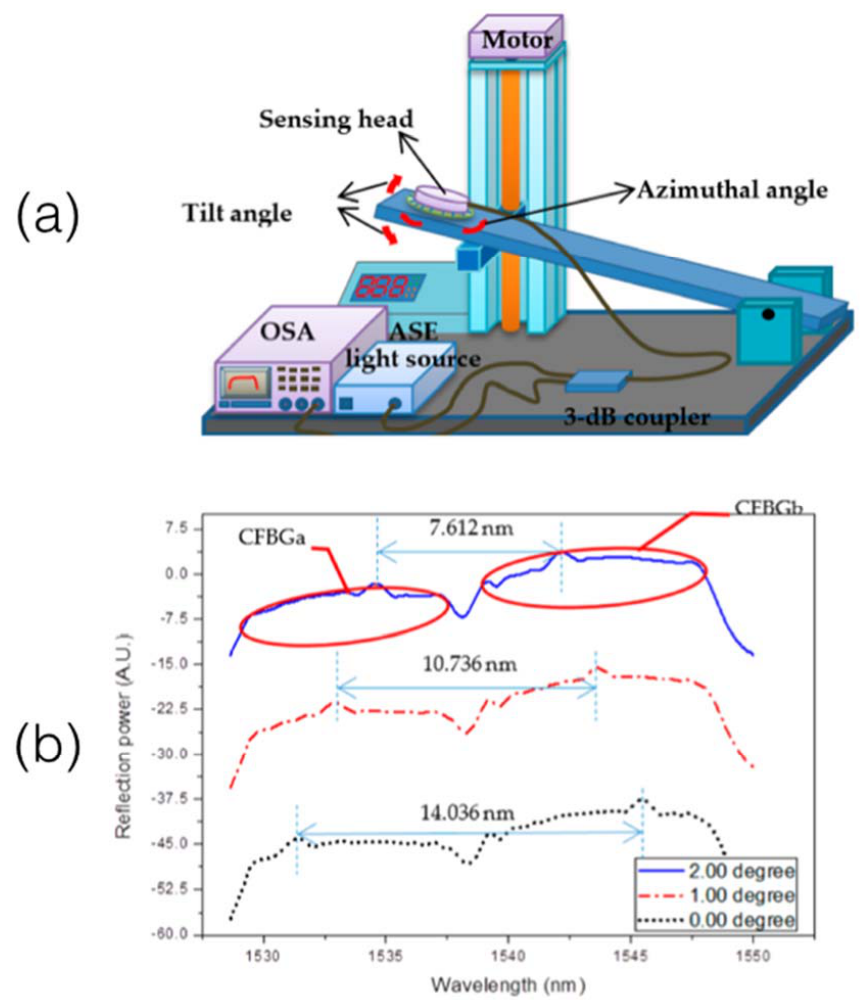
Figure 14. 2D inclinometer reported by Chang et al. based on a pair of CFBGs. ( a ) Schematic of the setup; ( b ) working principle. Image adapted from [53]. setup; ( b ) working principle. Image adapted from